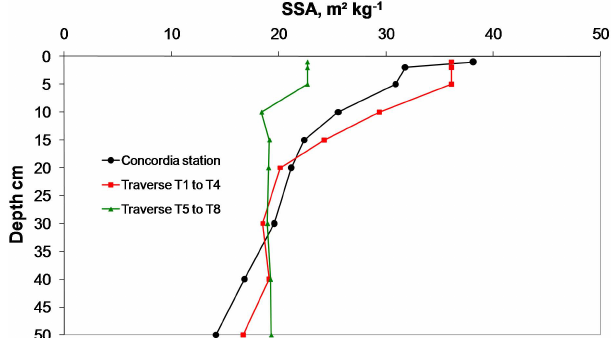
Fig. 10. Mean SSA profiles at DC and along the traverse.